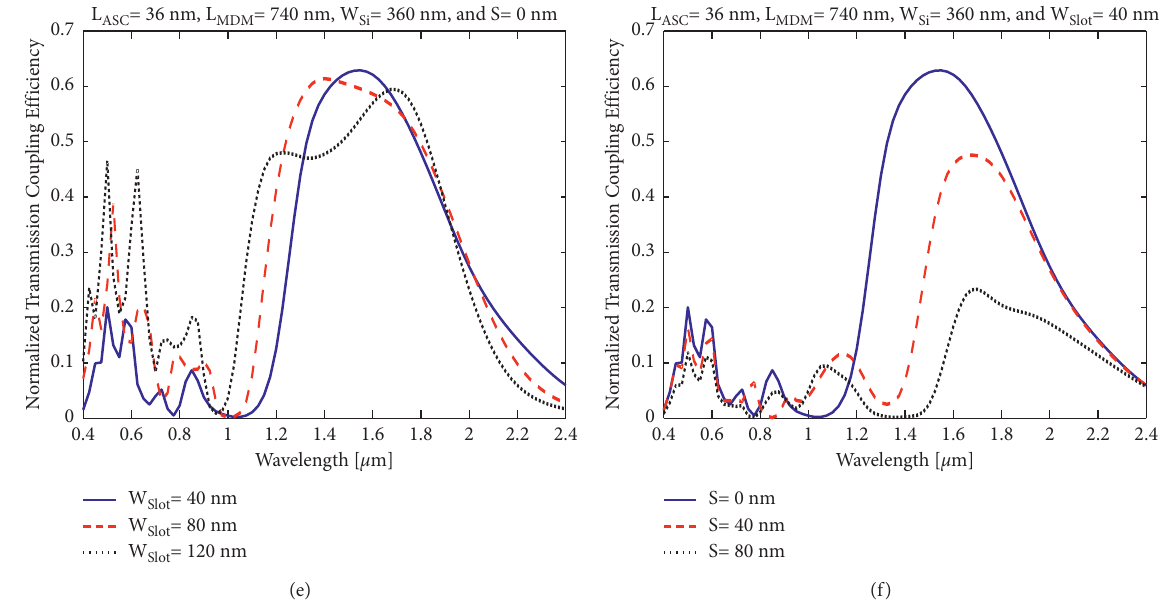
Figure 5: (a) A schematic of our proposed ASC #4 that shows the design parameters and (b–f) dependence of the spectrum response of ASC #4 on the length of the air-slot coupler L ASC , the length of the MDM plasmonic waveguide L MDM , the width of the silicon waveguide W , and the misalignment between the position of the air-slot waveguide with respect to the center of the width of the slot waveguide W Slot silicon waveguide S ,